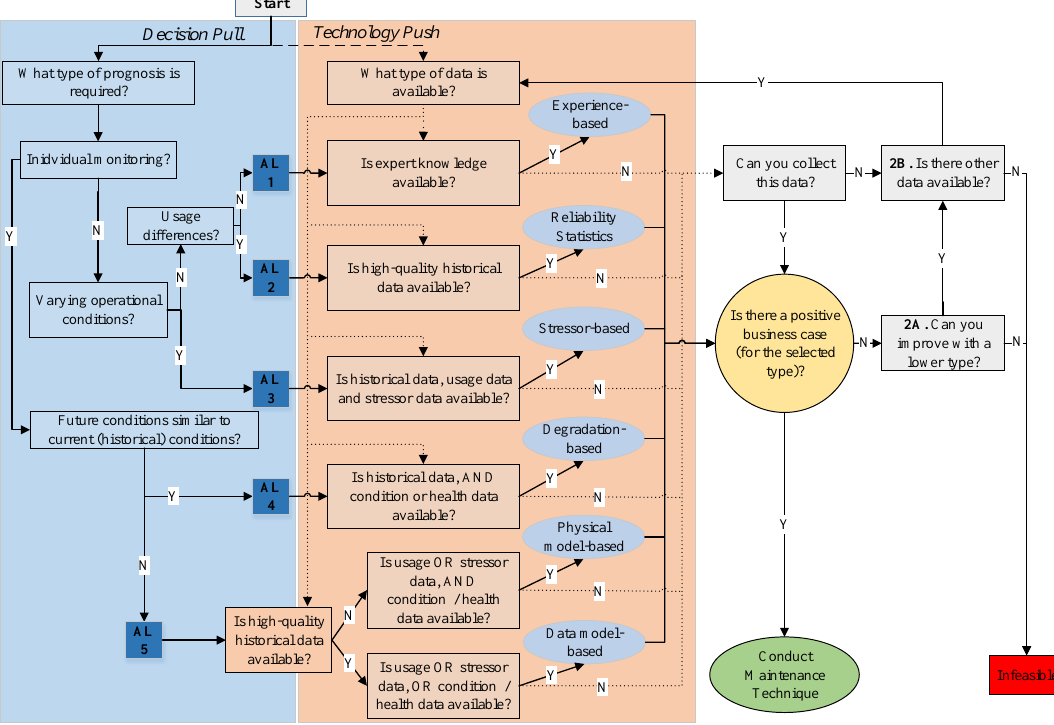
Figure 5. Proposed preventive maintenance approach selection framework.